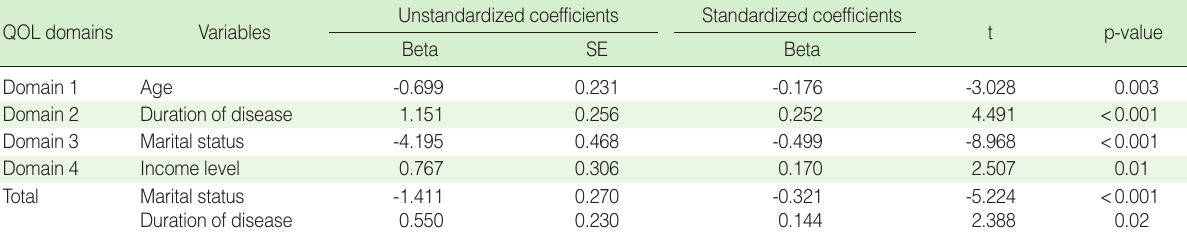
Table 6. Reverse multiple linear regression analyses of factors significantly associated with